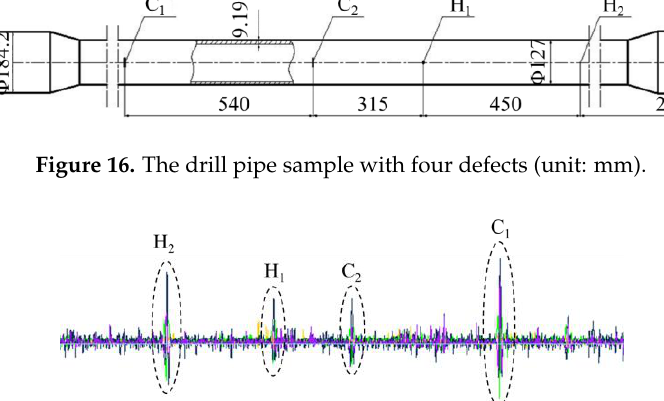
Figure 15. The whole MFL testing apparatus at the wellhead.